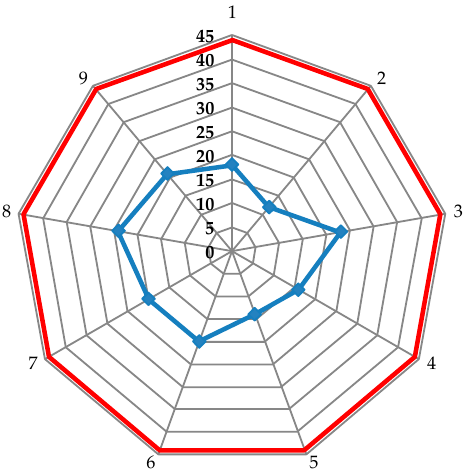
Figure 5. Data for BFS measured for 9 fires on three packages made of 12 layers of SB1plus fabric.